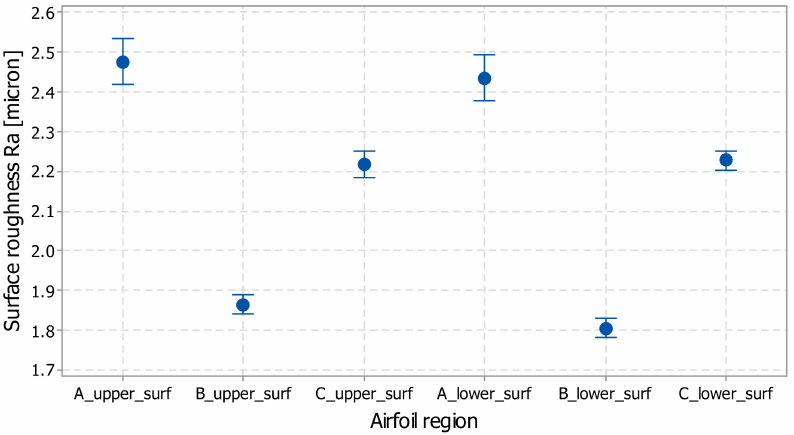
Figure 13. Interval plot of surface roughness for airfoil regions (matte XY orientation); bars are one standard error from the